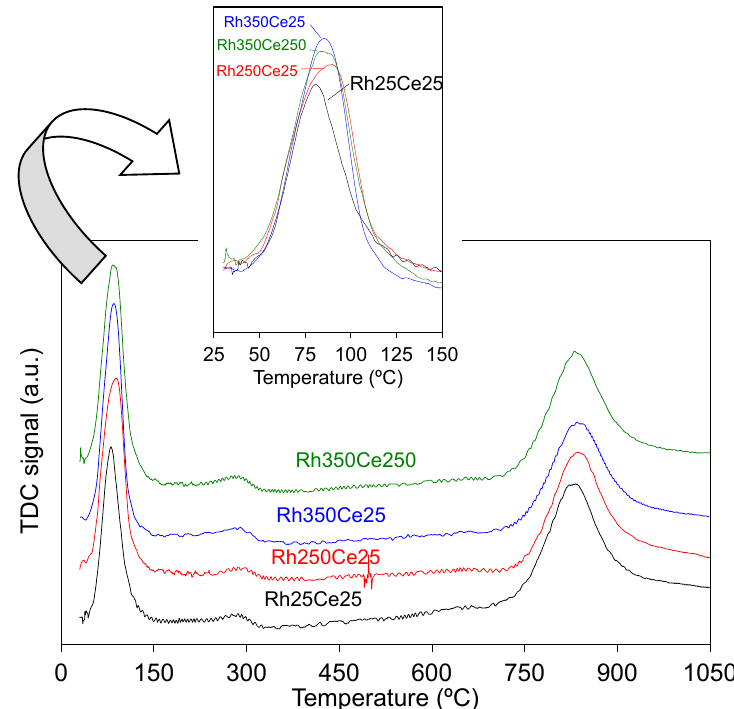
Figure 7. H 2 -TPR profiles of fresh catalysts after an in situ pretreatment with 5% O 2 /He at 500